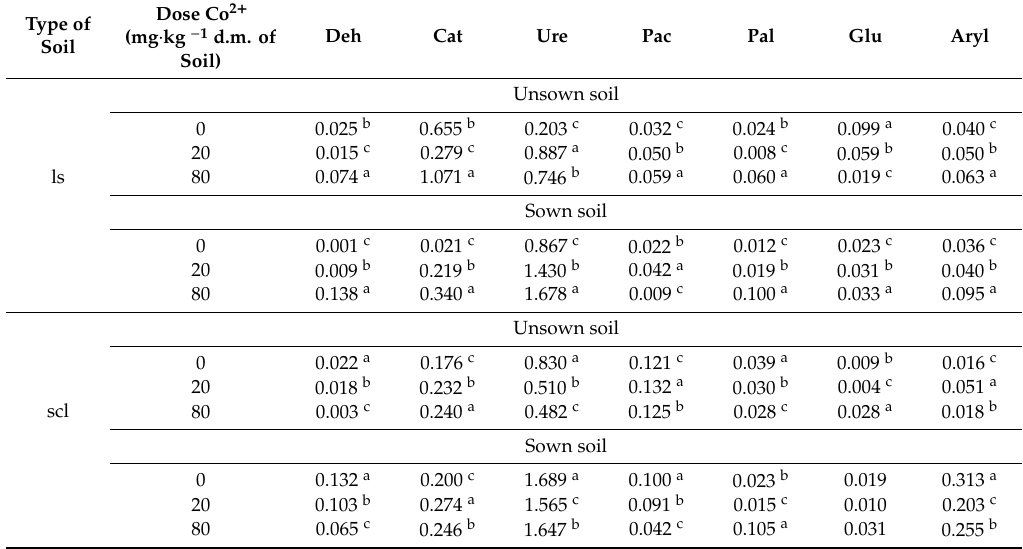
Table 12. Index of molecular sieve e ff ect ( IF s ) on the activity of enzymes in soil. Type of